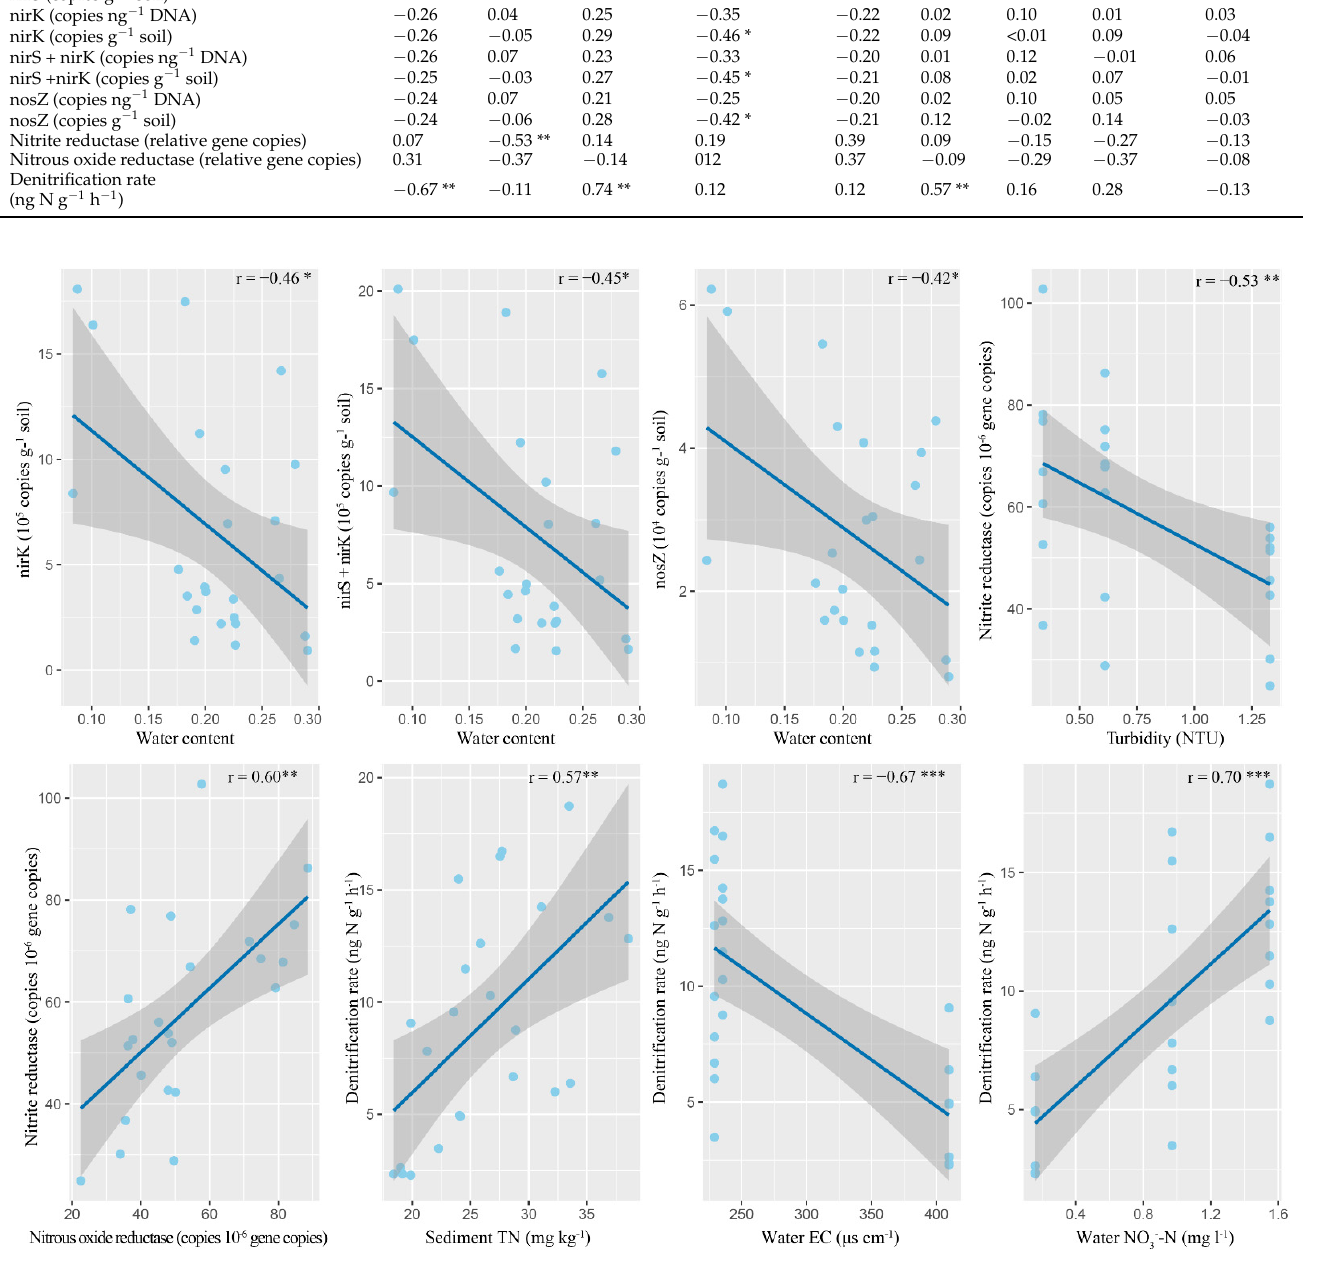
Figure 4. Significant Pearson correlations between denitrification rates, water parameters, sediment parameters, gene abundances, and enzyme activities. * significant level < 0.05; ** significant level < 0.01; ***significant level < 0.001. Table 3. Different denitrification gene abundances and enzyme activities under different particle sizes and heterogeneities and reaches as illustrated by the Kruskal–Wallis test. Values in bold indicate significant differences ( p < 0.05). Microbial Abundance and Enzyme Activity Reach Particle Size Particle Heterogeneity